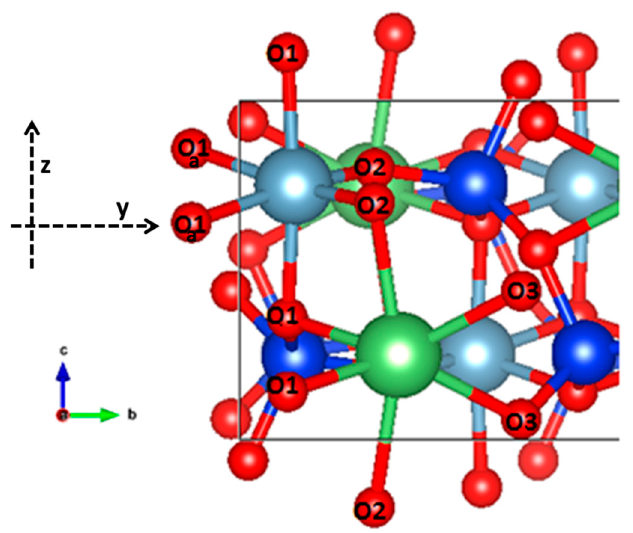
Figure 5. The sketch of the crystal structure of spodumene projected down a axis, made on the base [1].